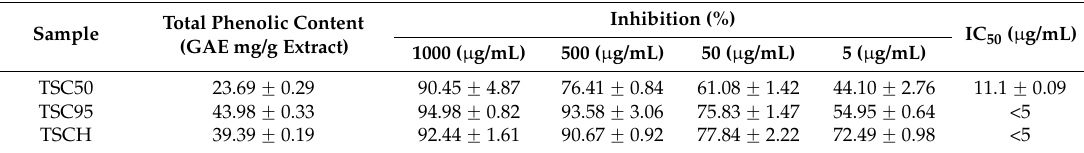
Table 1. Extraction process, total phenolic content and superoxide anion scavenging activity of tamarind seed coat on various extractions.